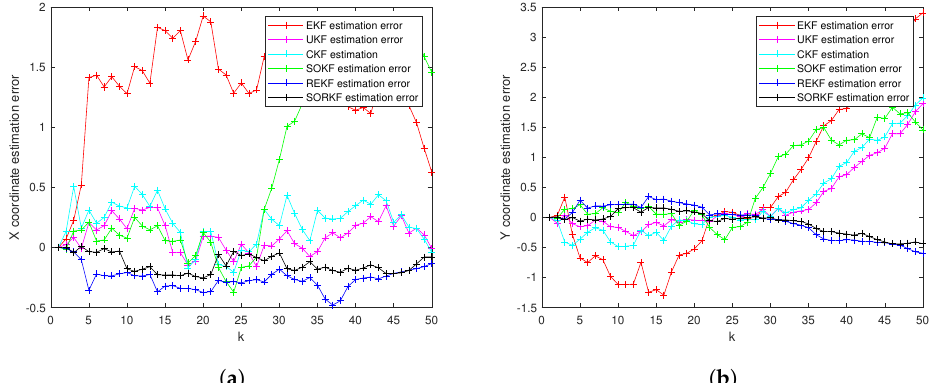
Figure 5. R1 estimation error of multi-robot in fixed formation. ( a ) X-Coordinate estimation error; ( b ) Y-Coordinate estimation